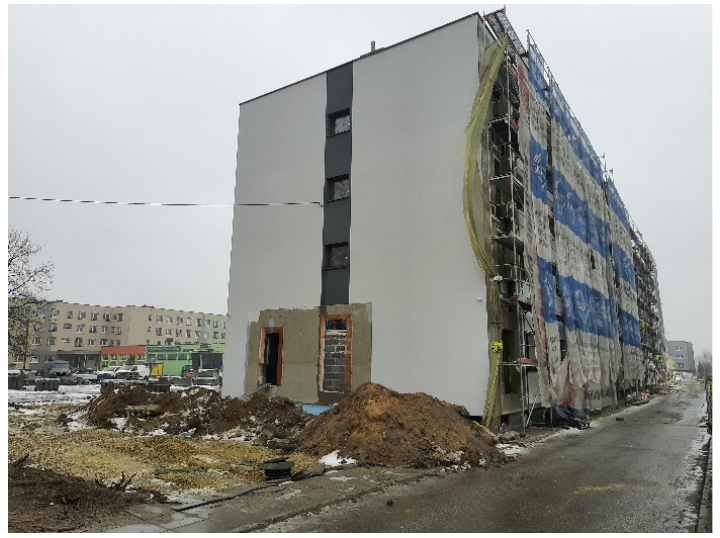
Figure 13. Example of improving residential functions—thermo-modernization of the estate. Additionally, to still present lack of full knowledge of retrofit techniques, these actions cannot fully stop the end of service life. LPS buildings were designed to last 50 years. It is assumed, theoretically, that properly managed maintenance can extend the service life for another 50 years [86]. At the same time, some of the buildings are already older than their design age. Exceeding their service life brings us inevitably to the prognosed end of service life. According to provisions of the Paris Agreement, the civil engineering sector should decarbonise globally by 2050. Thus, effective strategies, based on the lifecycle of redesigned materials to be less resource intensive, acquiring waste as a resource to manufacture new materials, are needed. Antonini et al. [87] assumed that reversibility and durability features can improve the circular resource flow. The durability was defined as the intensive correlation between the maintenance of a building object and its features and the ability to maintain technical efficiency . Thus, the aging of materials due to exploitation and environmental impact results in the process of gradual durability loss. The durability of load-bearing elements, according to [88], is determined by two parameters: the ultimate limit state (strength and stability) and the limit of stiffness (serviceability limit state). Konior, in his research on durability [89], stated that the durability of building materials and their components depends on the period in which a properly operated product remains fit for the intended use. If the serviceability falls below the established minimum standard, this results in a partial or complete loss of durability, thus a renovation is needed (Figure